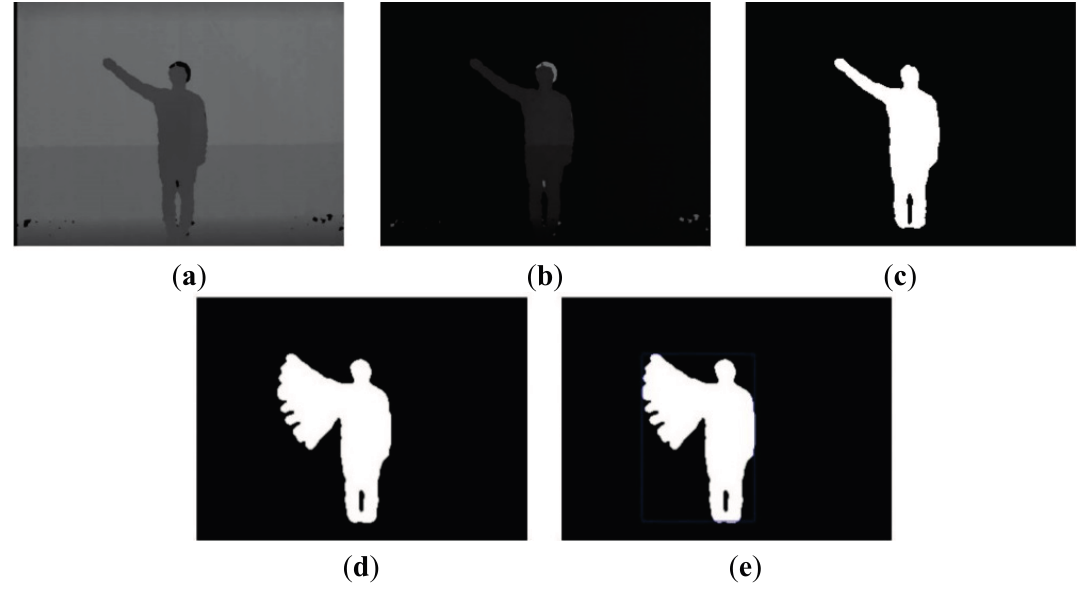
Figure 13. Example of handing action detection process: ( a ) depth image; ( b ) difference image; ( c ) median filter image; ( d ) MHI image; ( e ) detection image.